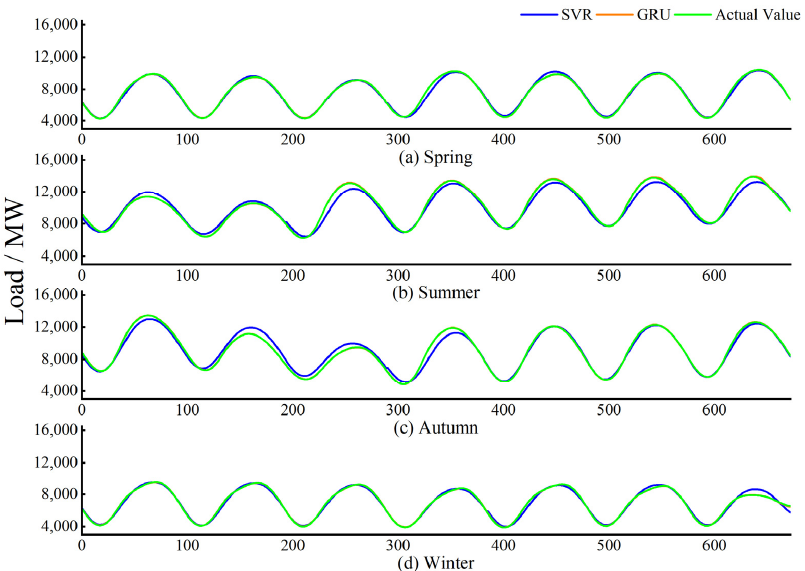
Figure 7. Point forecasting results of dataset B.